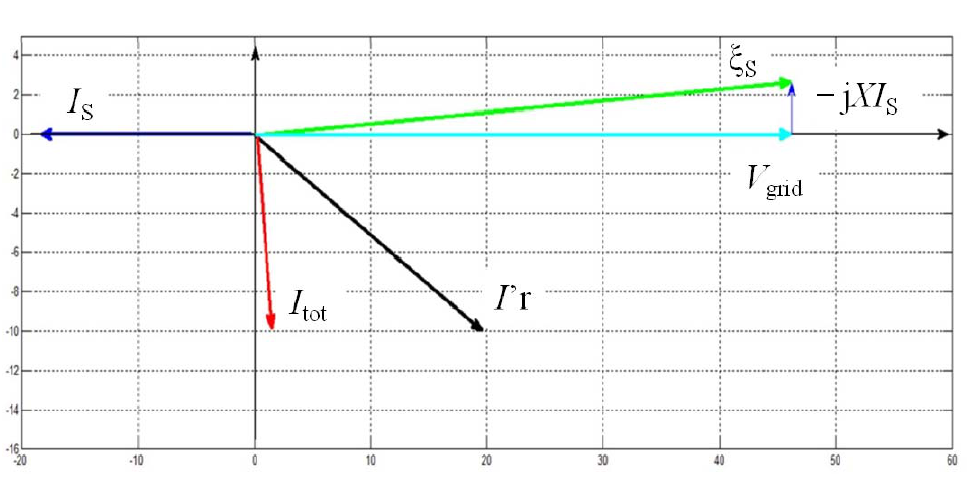
Figure 2. Space phasor representation of DFIG system electric variables in steady-state and ξ are scaled to fit in the conditions. V grid S